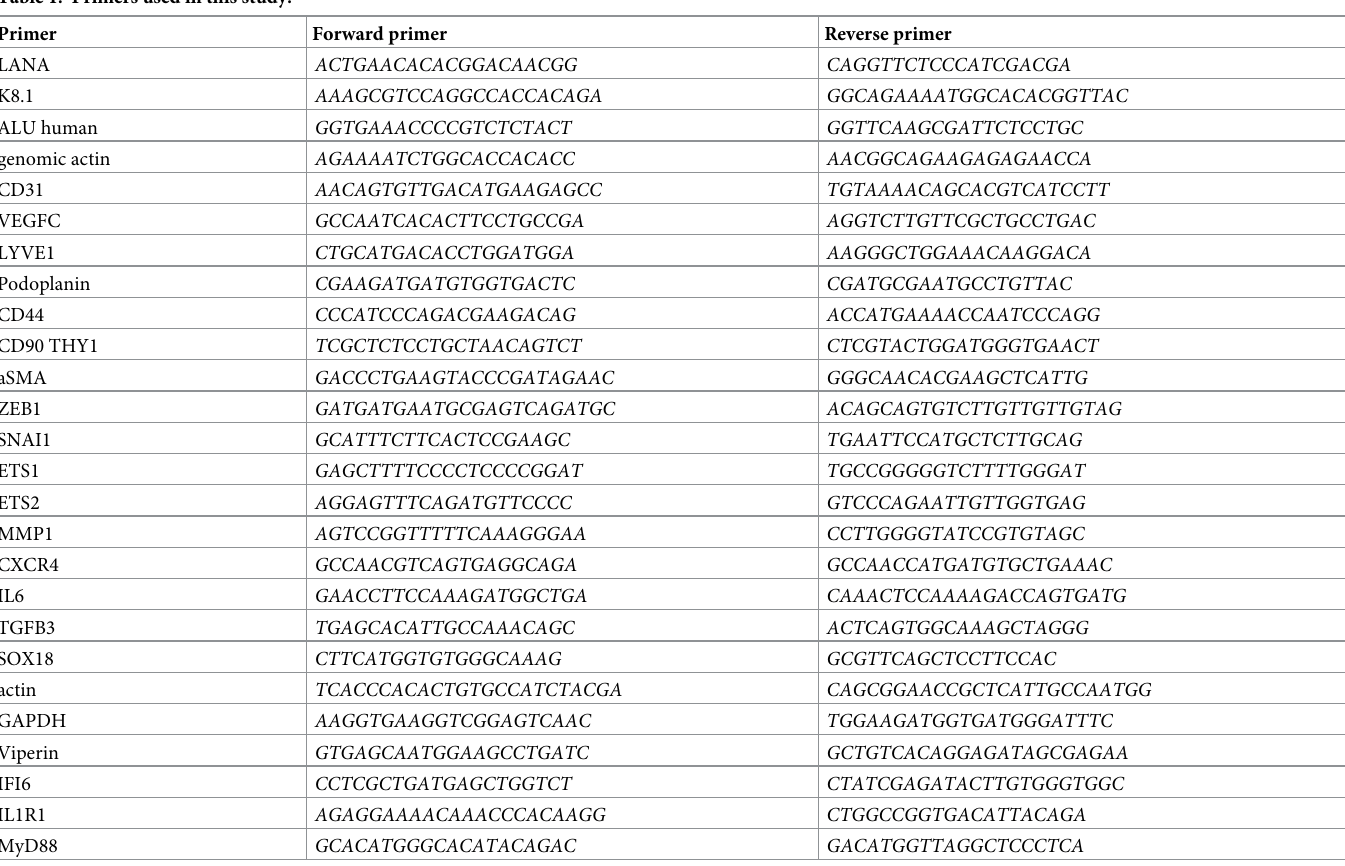
Table 1. Primers used in this